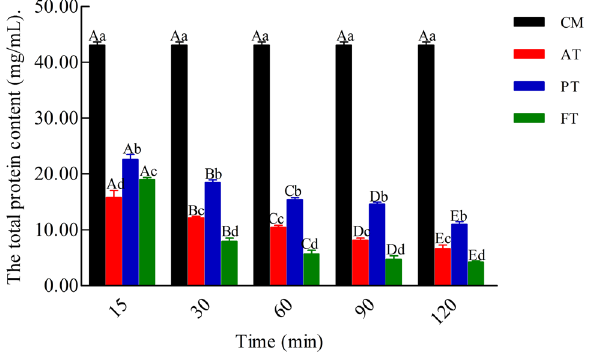
Figure 5. Effect of different enzymatic hydrolysis on the total protein of cow milk (mg/mL). Alcalase-treated cow milk (AT), Protamex-treated cow milk (PT), Flavourzyme-treated cow milk (FT). Each value represents the mean of three independent experiments ± SD. Different letters indicate significant differences among groups ( P <